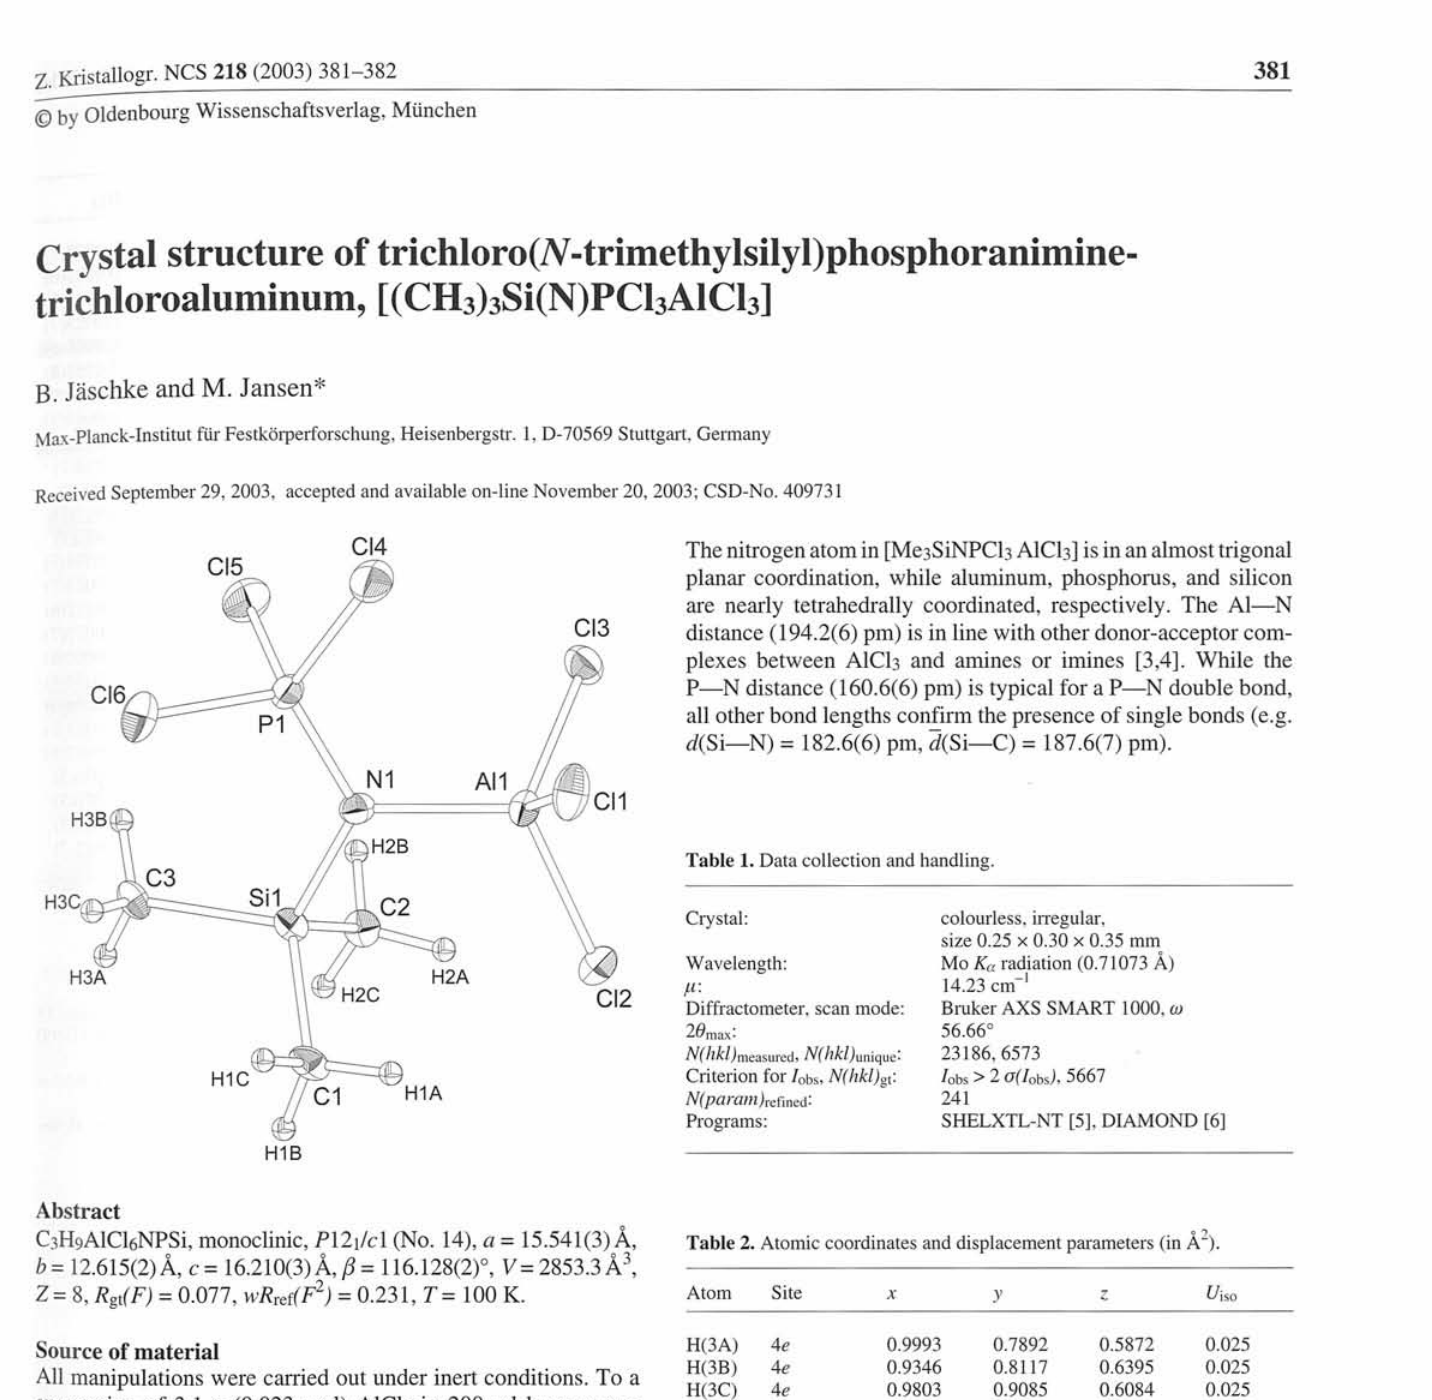
Table 2. Atomic coordinates and displacement parameters (in A 2